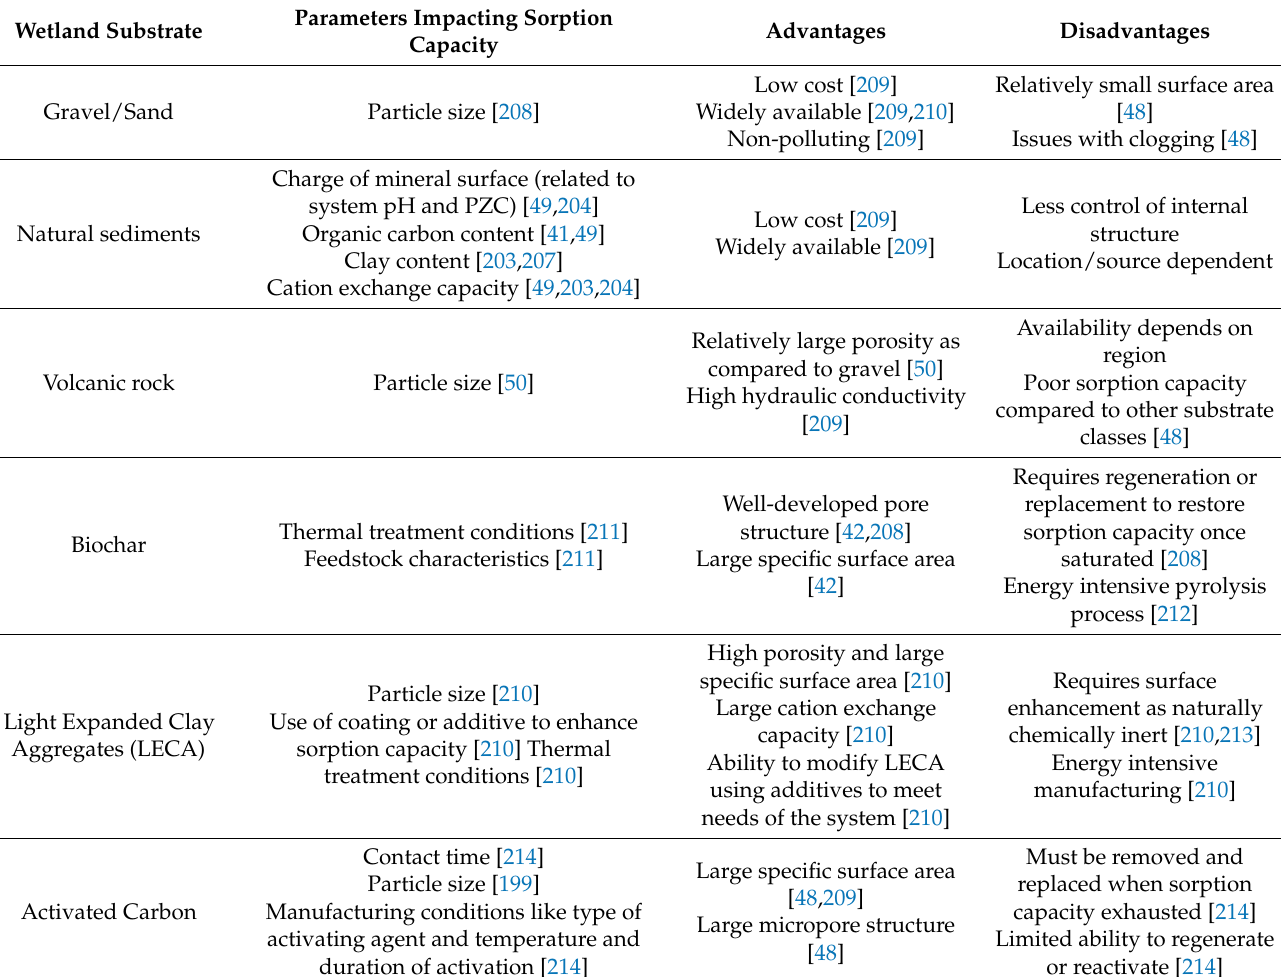
Table 4. Parameters of wetland substrates that impact the sorption capacity and system